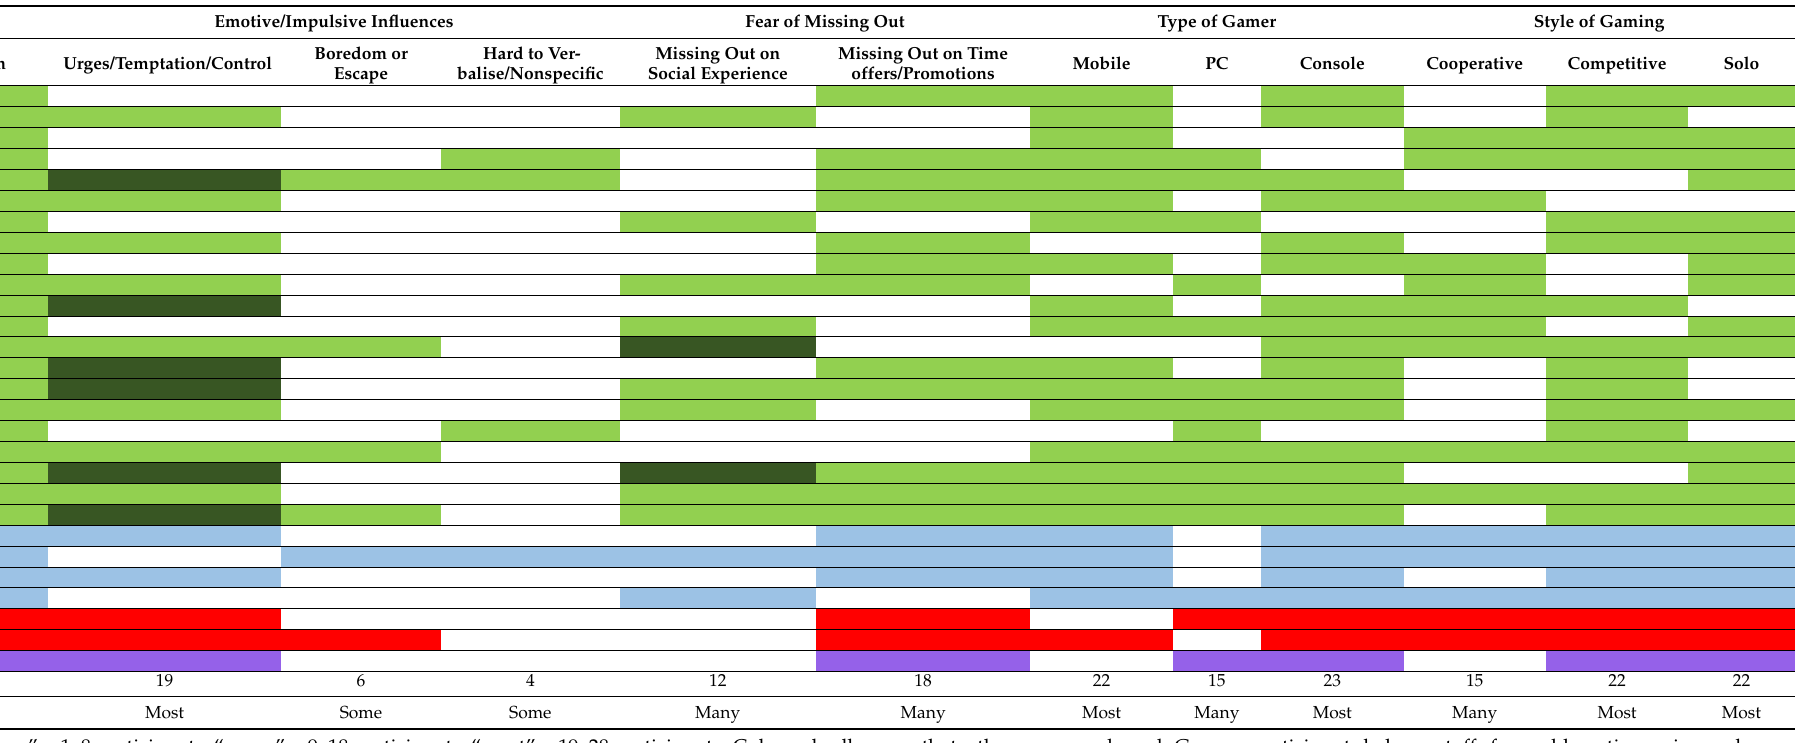
Table 4. Distribution of themes across the sample for emotive/impulsive influences, fear of missing out, type of gamer and style of gaming. Theme Emotive/Impulsive Influences Fear of Missing Out Type of Gamer Style of Gaming Missing Out on Time offers/Promotions Mobile PC Console